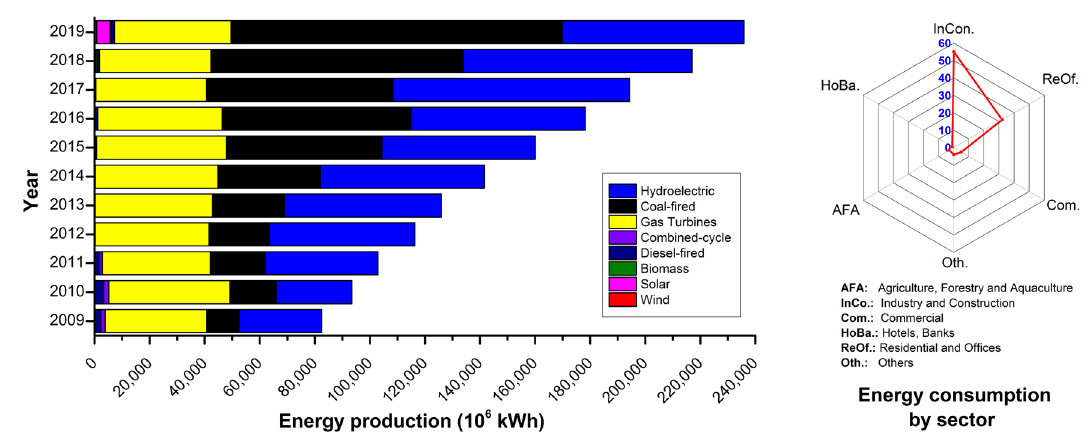
Figure 2. Total energy production from several sources in Vietnam in 2009–2019 (left), and energy consumption by sectors in 2019 (right)